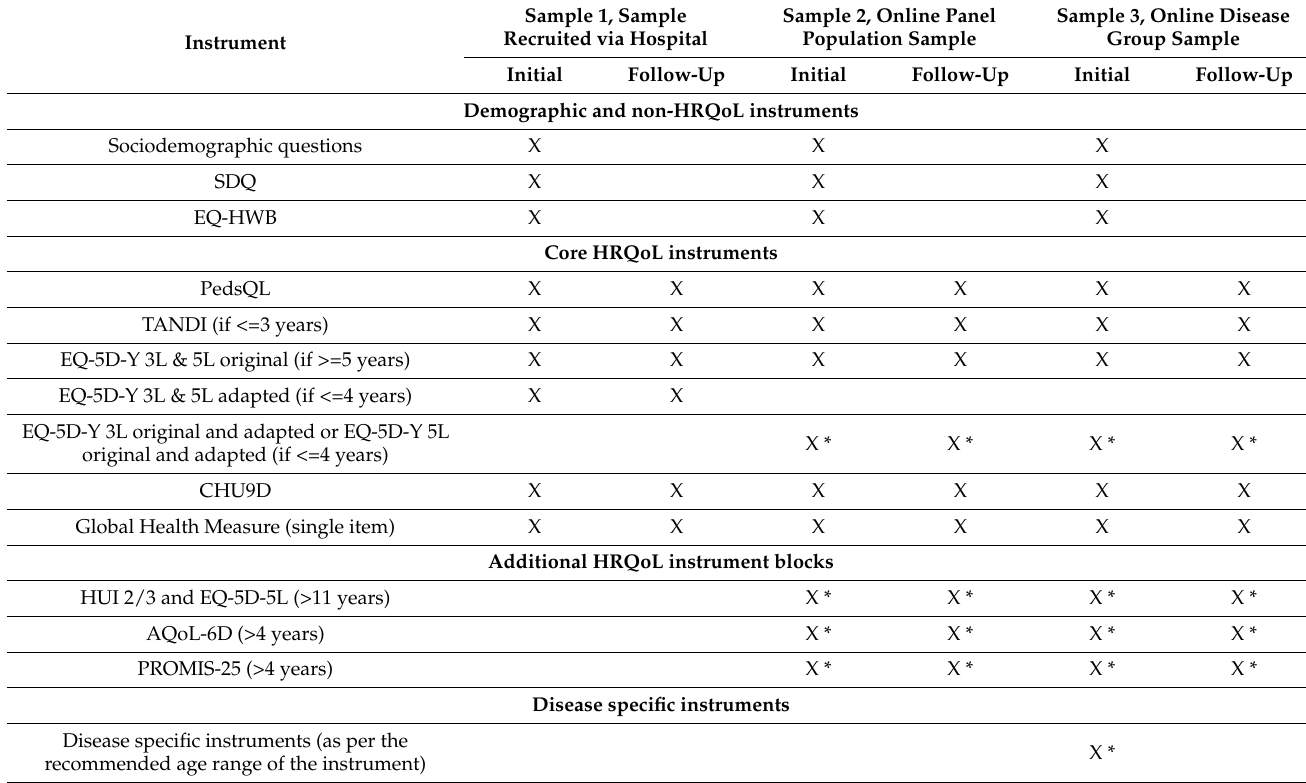
Table 1. Summary of instruments by study